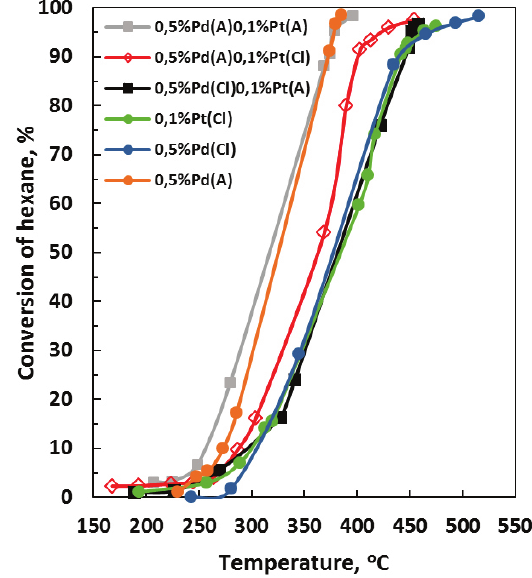
Figure 3: Comparison of under-air hexane oxidation over Pd, Pt, and Pd-Pt catalysts depending on precious metal precursor. Precursor denotations: (A) – Pt or Pd nitrate solution and (Cl) – Pt H PtCl or Pd PdCl . Experimental conditions: feed composition 2 6 2 – 1500 ppm hexane under air, GHSV at 11.060 h -1 , atmospheric